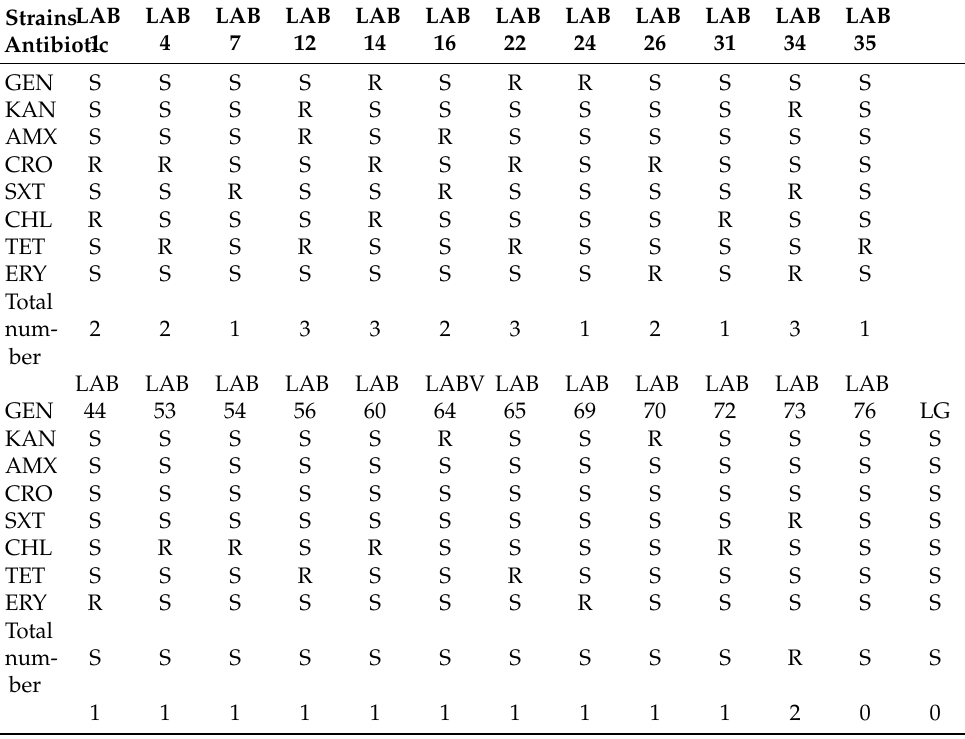
Table 1. Drug resistance of 24 strains of lactic acid bacteria.